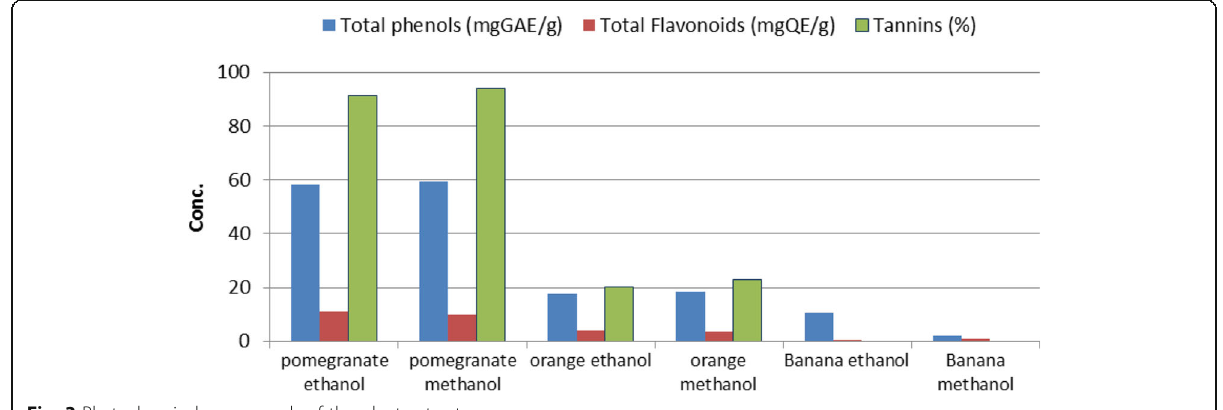
Fig. 3 Phytochemical compounds of the plant extracts